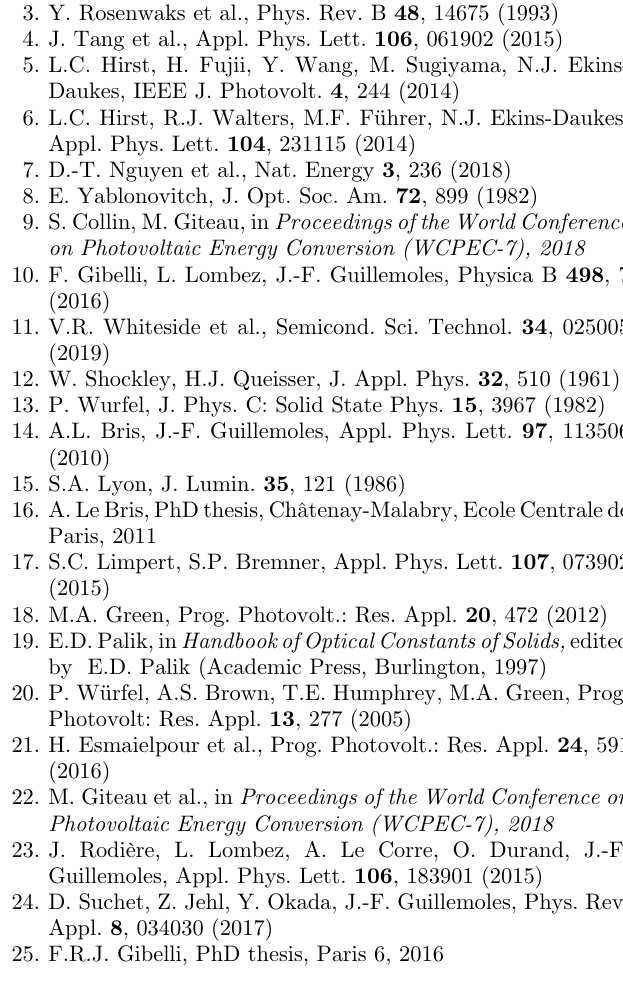
Figure S3 Extracted current (per sun) as a function of the applied voltage for a thermalized GaAs cell in the radiative limit for different values of homogeneous